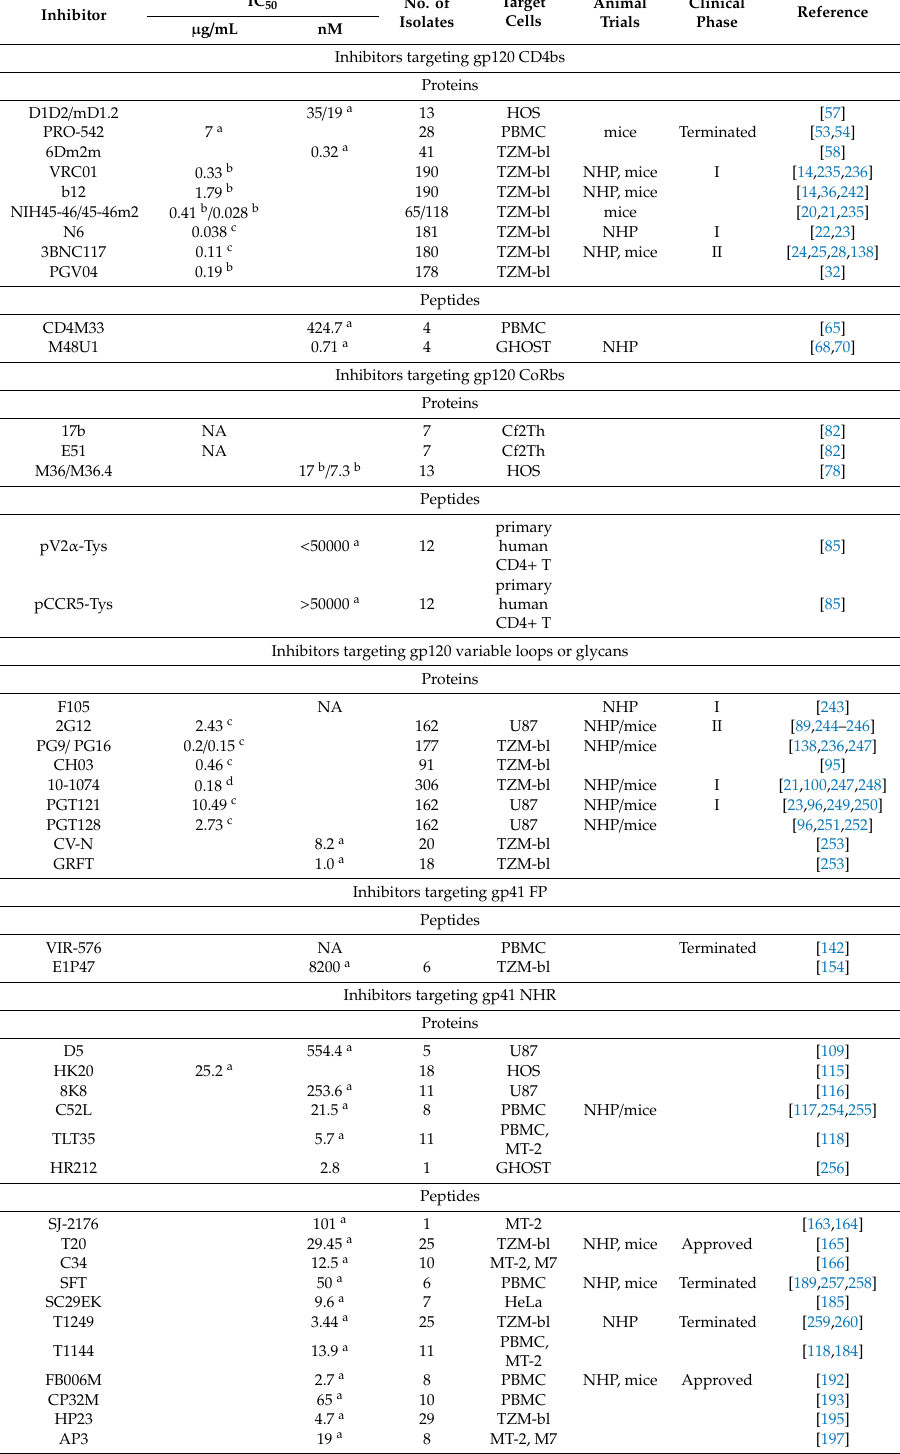
Table 1. Protein-and peptide-based HIV entry inhibitors targeting gp120 or gp41.